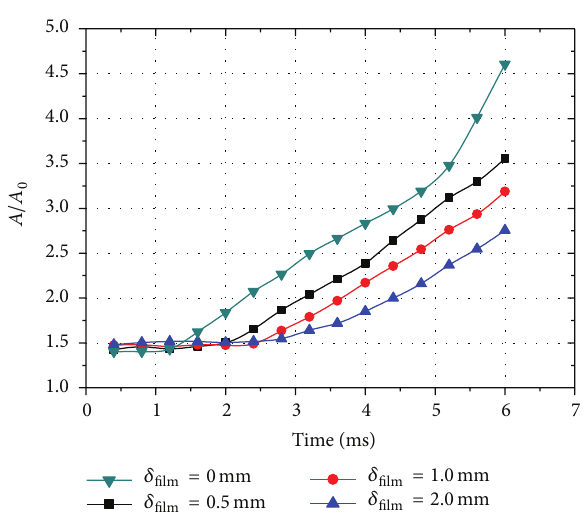
Figure16:Aspectratioofdropletsurfaceareawithtimefordifferent film thicknesses.